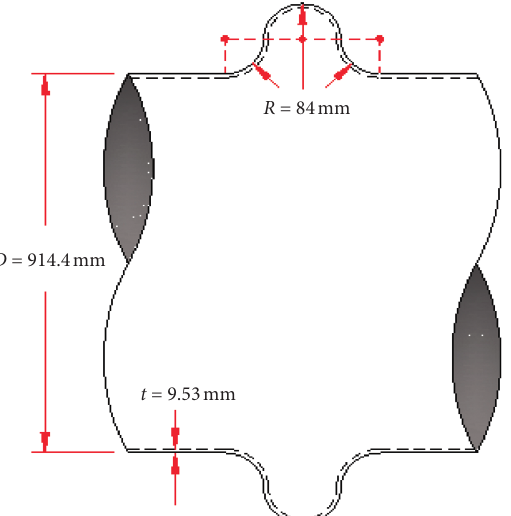
Figure 5: Geometric properties of waved connection used in the numerical model.